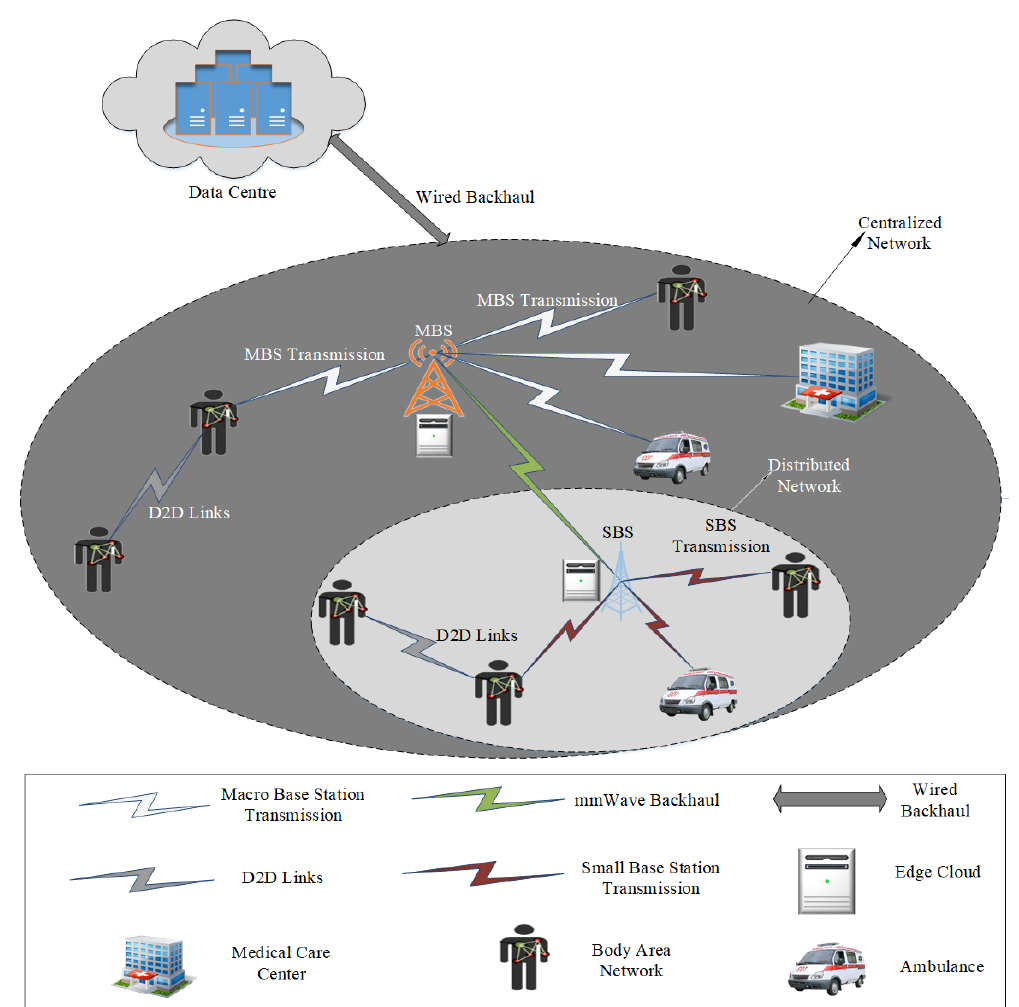
Figure 1. A general architecture of smart health-care network based on